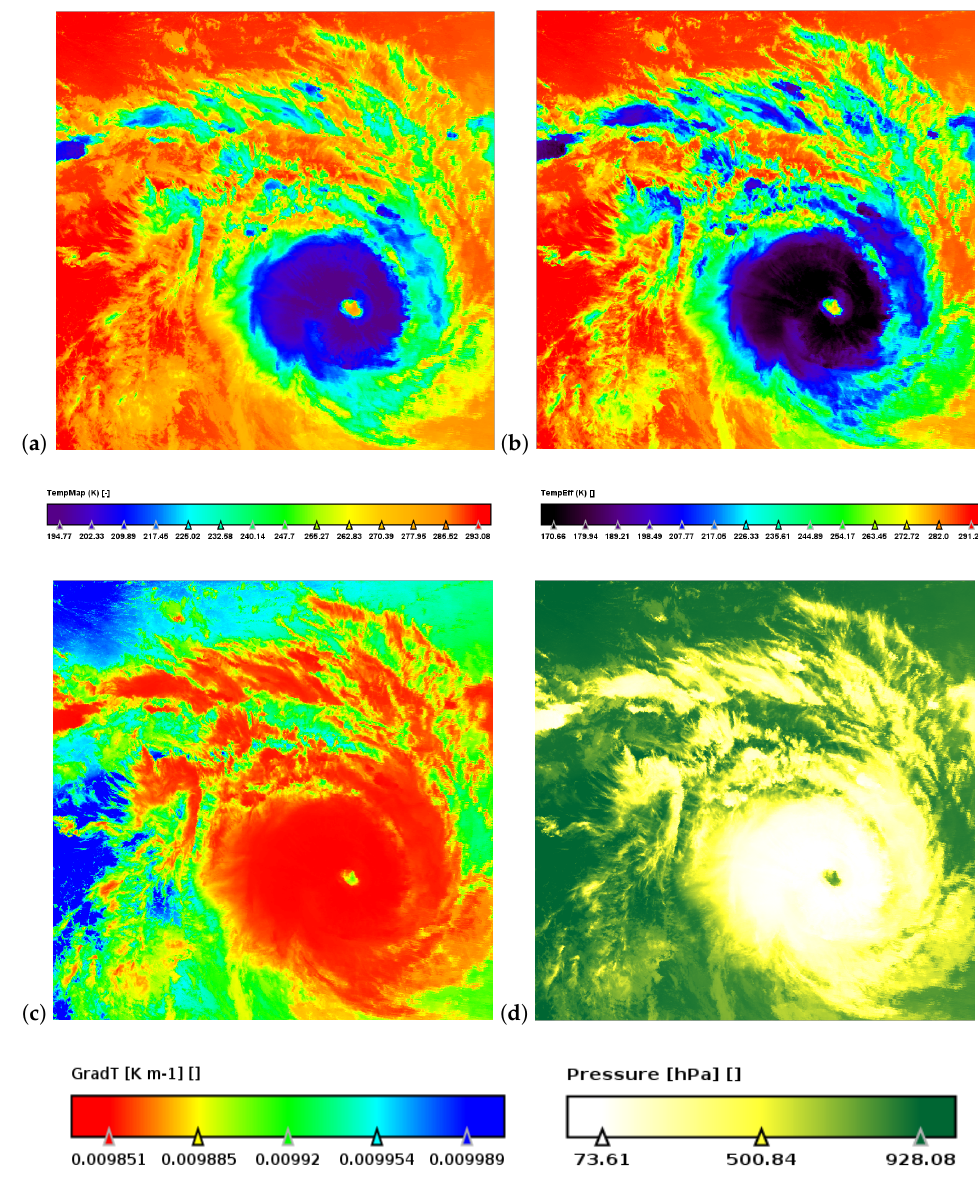
Figure 11. Example of postprocessing applied to data of all the three sensors, showing the MODIS— Terra image of 8 February 2021, 05.20 UTC. Scene coordinates: from left to right on the top (74.16 ◦ E, 7.20 ◦ S)–(84.38 ◦ E, 7.13 ◦ S), on the bottom (74.15 ◦ E, 16.3 ◦ S)–(84.56 ◦ E, 15.37 ◦ S). T b ( a ), T ef f ( b ), |∇ T | ( c ) and pressure field ( d